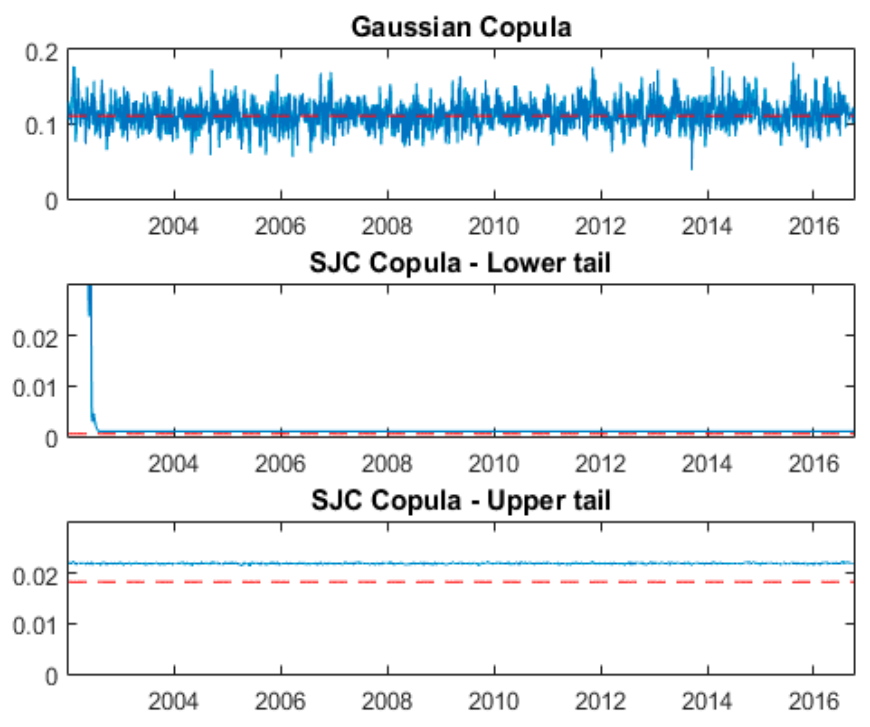
Figure 7. Dependence path of the time-varying copula for PM 10 –O 3 .